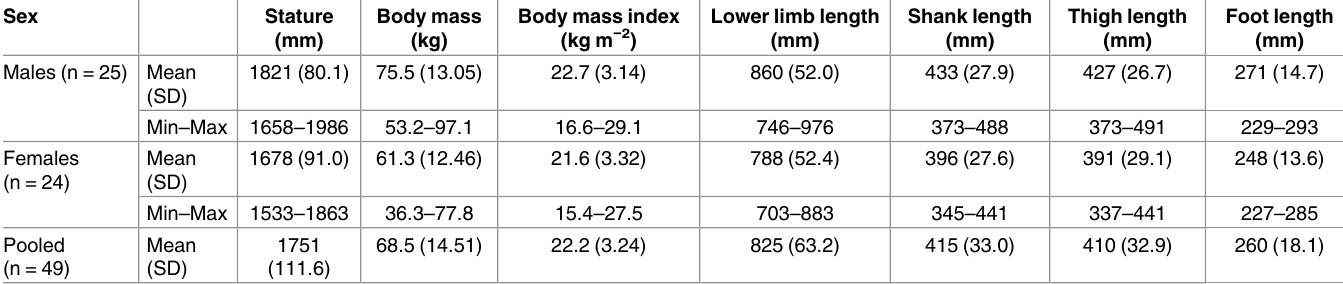
Table 1. Sample statistics of anthropometric